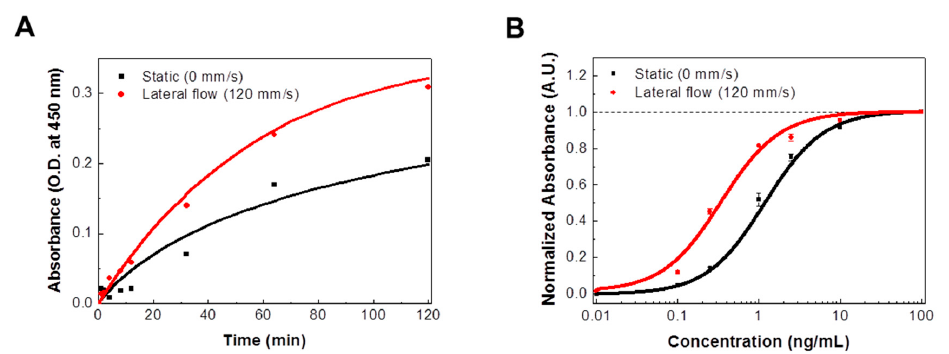
Figure 3. Effects of lateral flow conditions on IL-13 antibody-antigen reactions: ( A ) Absorbance values of bound IL-13 antigens to IL-13 antibody-coated substrates with or without lateral flows (120 mm/s); ( B ) Dose-response of IL-13 antibody-coated substrates to IL-13 antigens with or without lateral flows (120 mm/s).